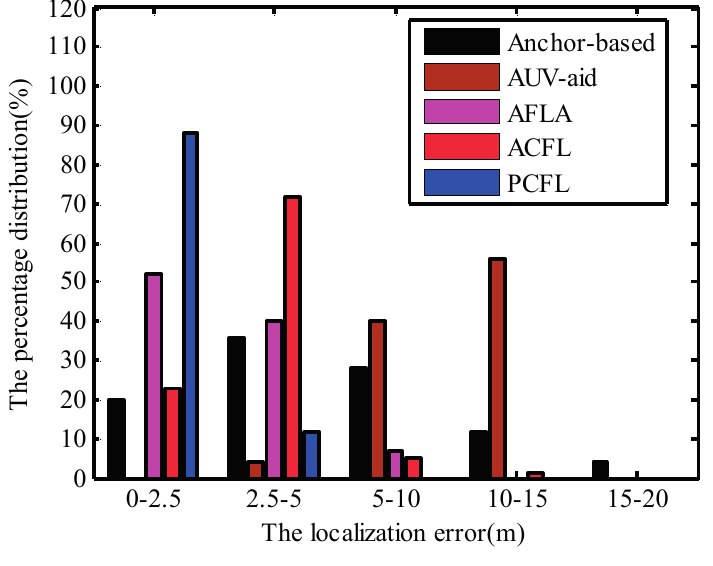
Figure 11. The percentage